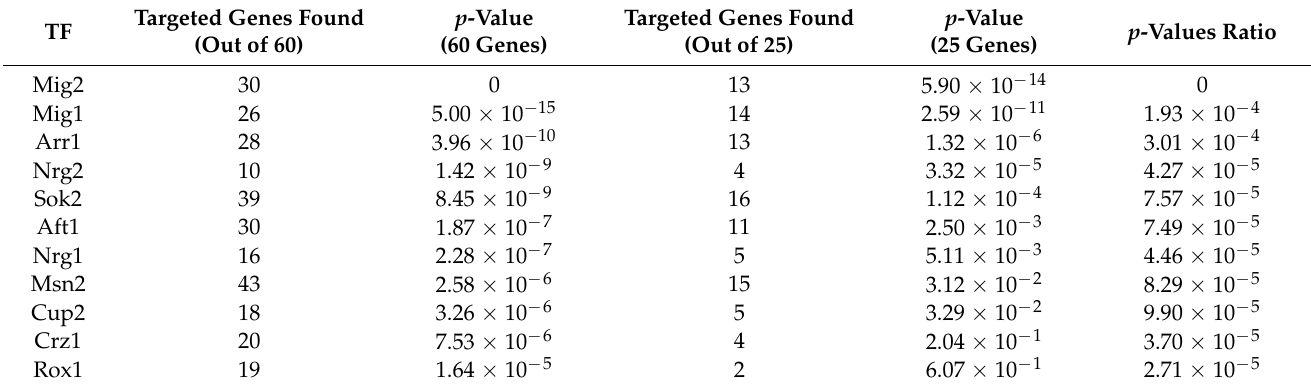
Table 2. Transcription factors (TF) controlling the set of genes upregulated by low glucose according to their dependence on Ppz1 overexpression, expressed as a p -value ratio. Only p -value ratios <1.00 × 10 − 3 are shown. The analysis was performed on data deposited at GEO (acc. # GSE199793).